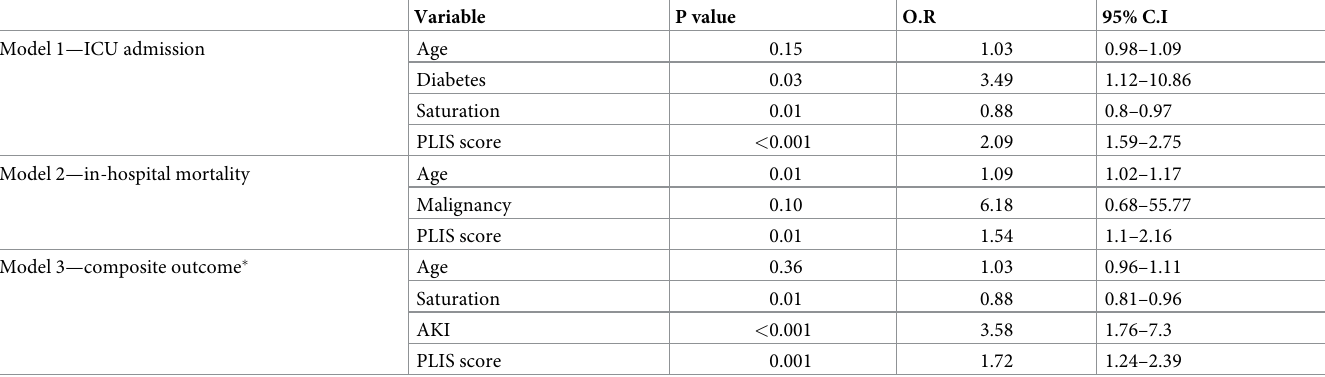
Table 4. Multivariate Generalized Estimating Equation (GEE) regression for study outcomes. Variable P value O.R 95%